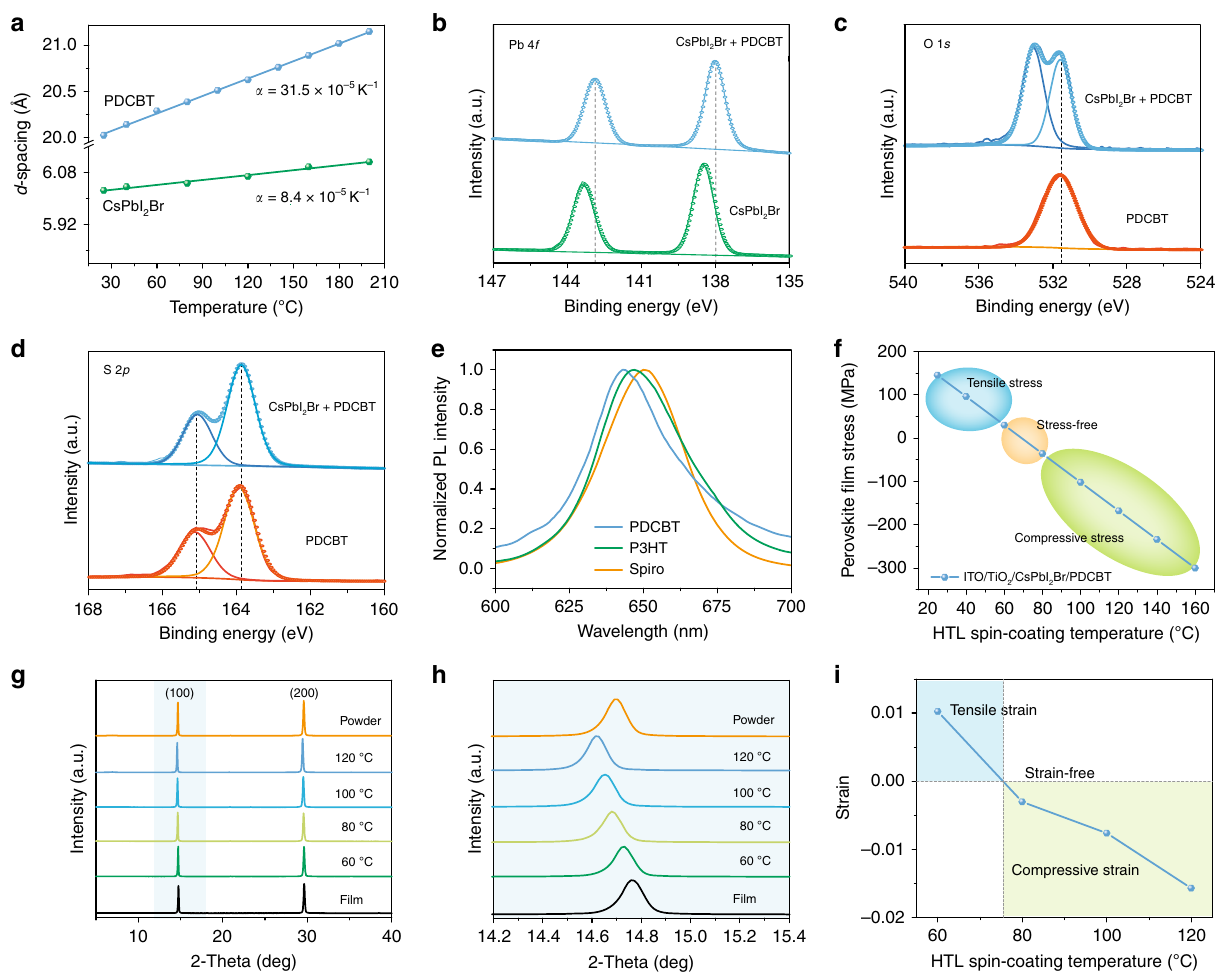
Fig. 2 Characterization of strain compensated perovskite thin fi lms. a Temperature-dependent (100) d-spacing of PDCBT and perovskite fi lms. XPS spectra of ( b ) Pb 4 f , ( c ) O 1 s and, ( d ) S 2 p in the perovskite, perovskite/PDCBT, and PDCBT fi lms. e Normalized PL spectra of perovskite fi lms with PDCBT, P3HT and Spiro-OMeTAD from the ITO side. f The calculated net average stress in perovskites within structures consisting of ITO/TiO 2 /perovskite/ PDCBT as a function of PDCBT spin-coating temperature. g XRD patterns of perovskite fi lm, powder and perovskite/PDCBT fi lms fabricated at different PDCBT spin-coating temperatures. h Magni fi ed (100) diffraction peaks in the region indicated by the blue. i Measured strain in perovskite fi lms coated with PDCBT HTLs at different spin-coating